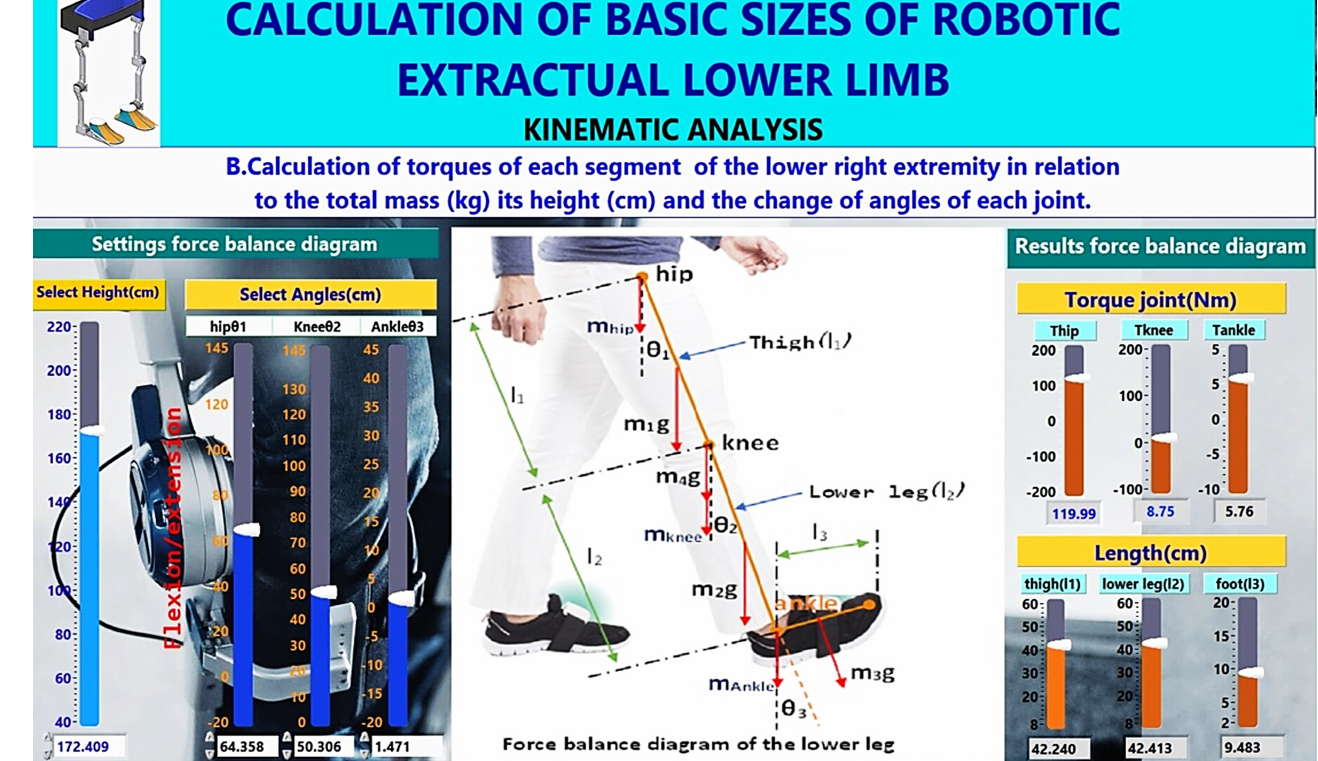
Figure 7. Calculation of the torques of each joint of the lower